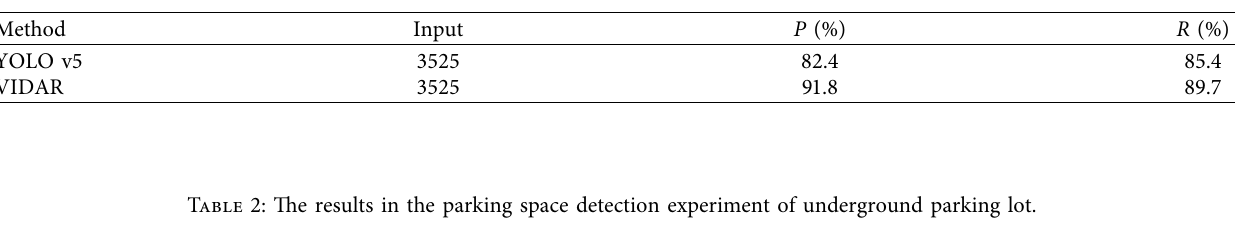
Table 1: The results in the parking space detection experiment of outdoor parking lot.